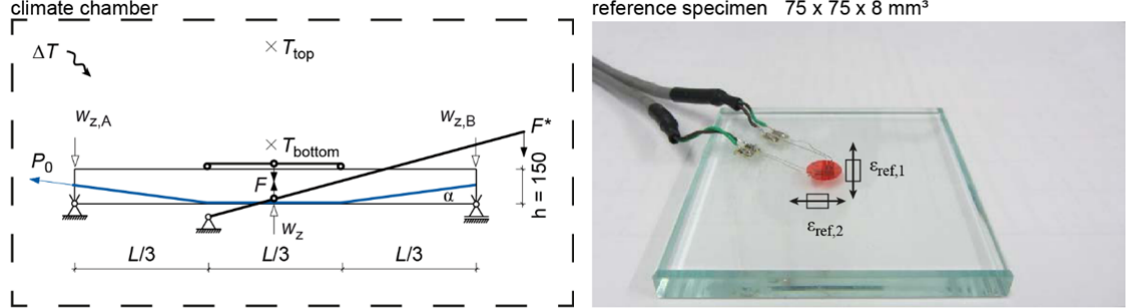
Fig. 5 Arrangement of test set-up (left). Unconstrained reference specimen